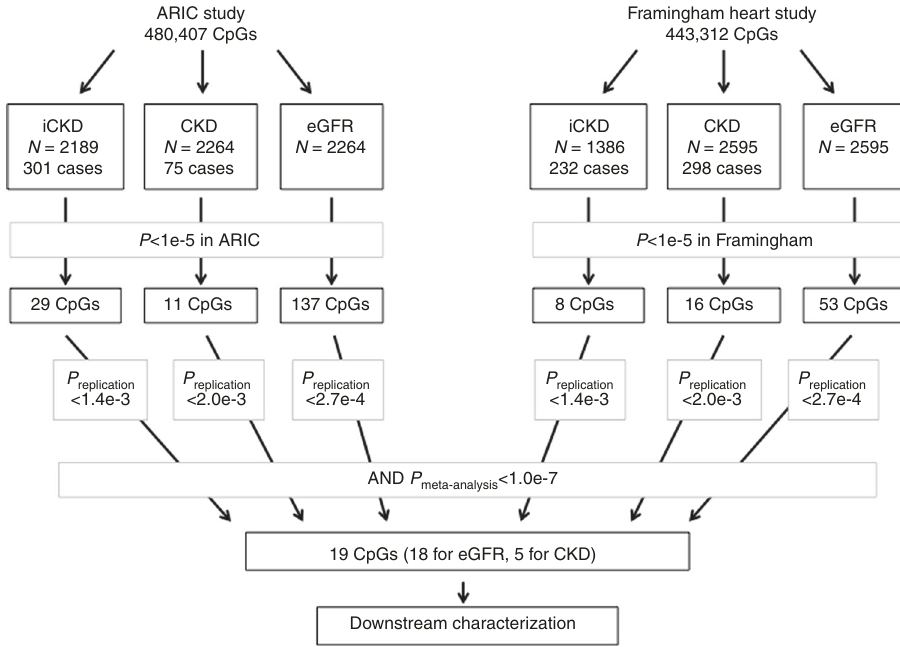
Fig. 1 Flowchart of the study design and summary of main results. The graph illustrates the number of CpGs that were examined at each step of the analysis and lists the total number of CpGs that were statistically signi fi cant at pre-de fi ned thresholds. The 19 replicated CpGs are unique; 4 of the 18 eGFR-associated sites were also associated with